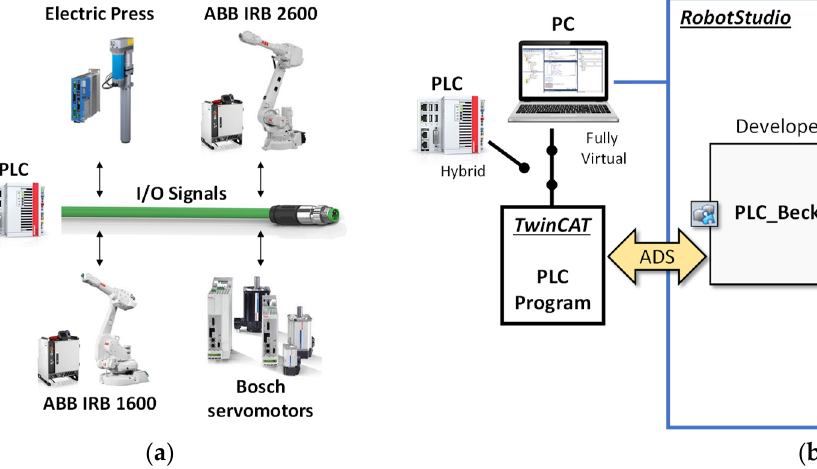
Figure 1. Conceptual representation of the proposed VC approach: ( a ) Typical hardware architecture of a robotic cell; ( b ) Representation in a virtual environment of the control architecture to maintain a correspondence between physical and virtual assets.